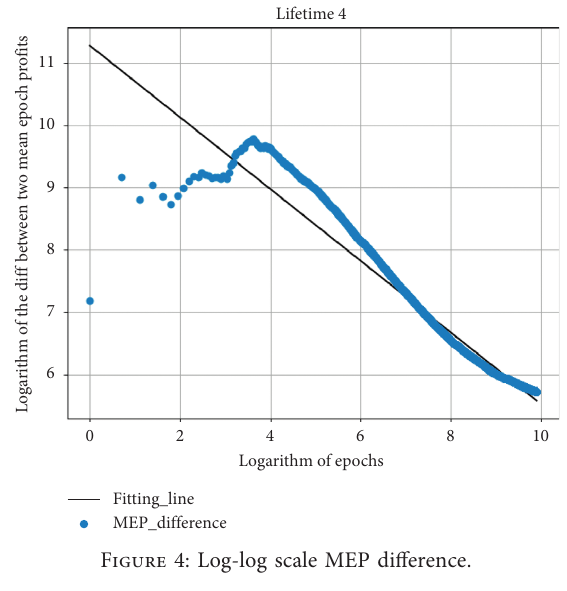
Figure 4: Log-log scale MEP difference.